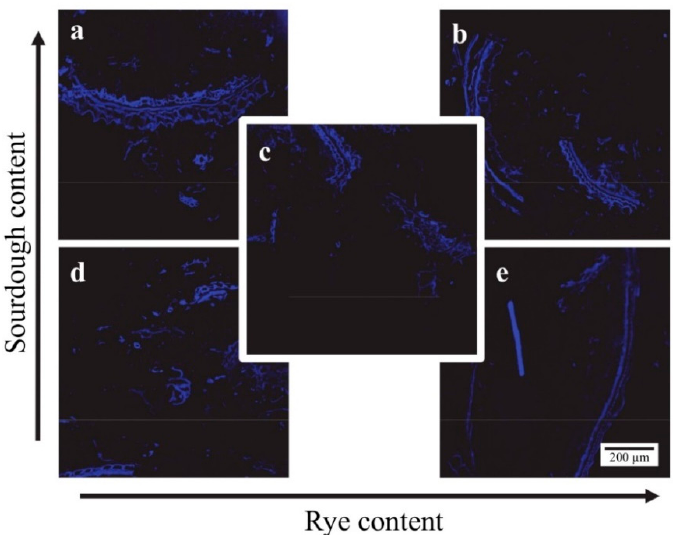
Figure 2. Fluorescence micrographs stained with calcoflour white. Beta-glucans are seen as blue. ( a ) high sourdough/low rye, ( b ) high sourdough/high rye, ( c ) medium sourdough/medium rye, ( d ) low sourdough/low rye, ( e ) low sourdough/high rye.